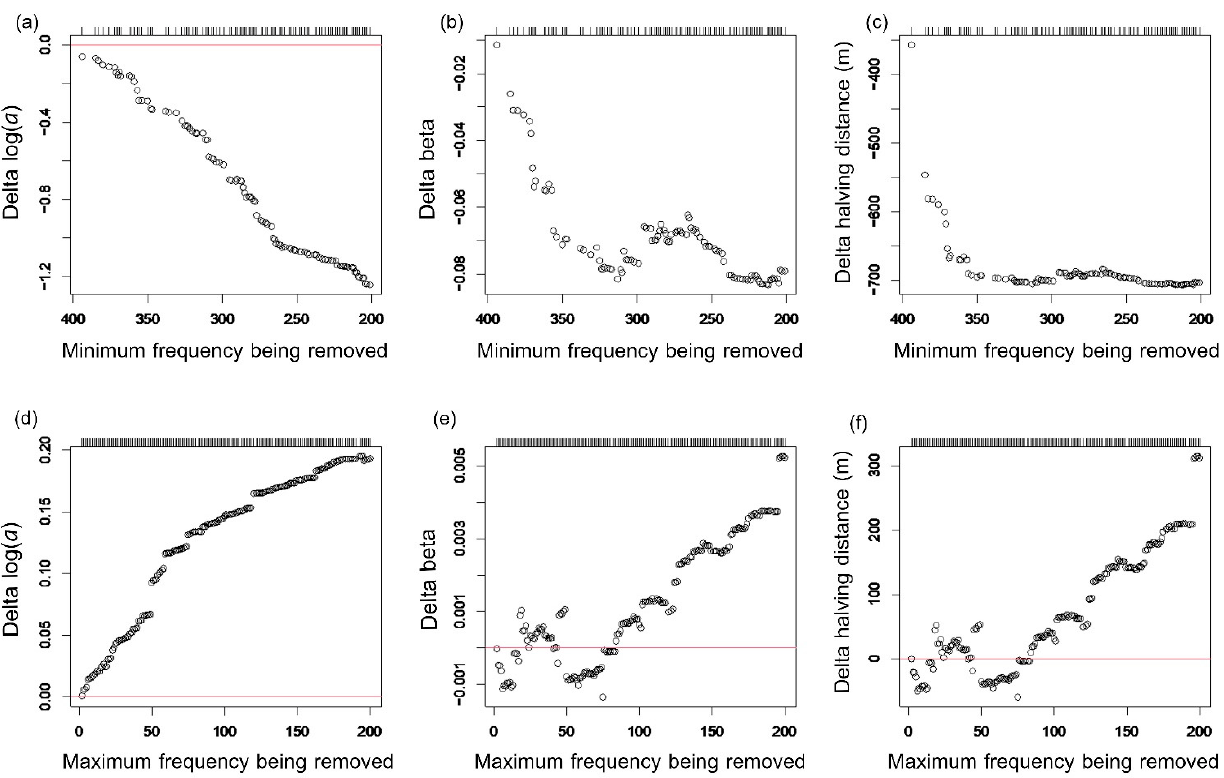
Figure 3. Effect of removal of specialists (top) and generalists (bottom) on initial similarity ( a , d ), slope ( b , e ), and halving distance ( c , f ) of distance–decay of similarity.